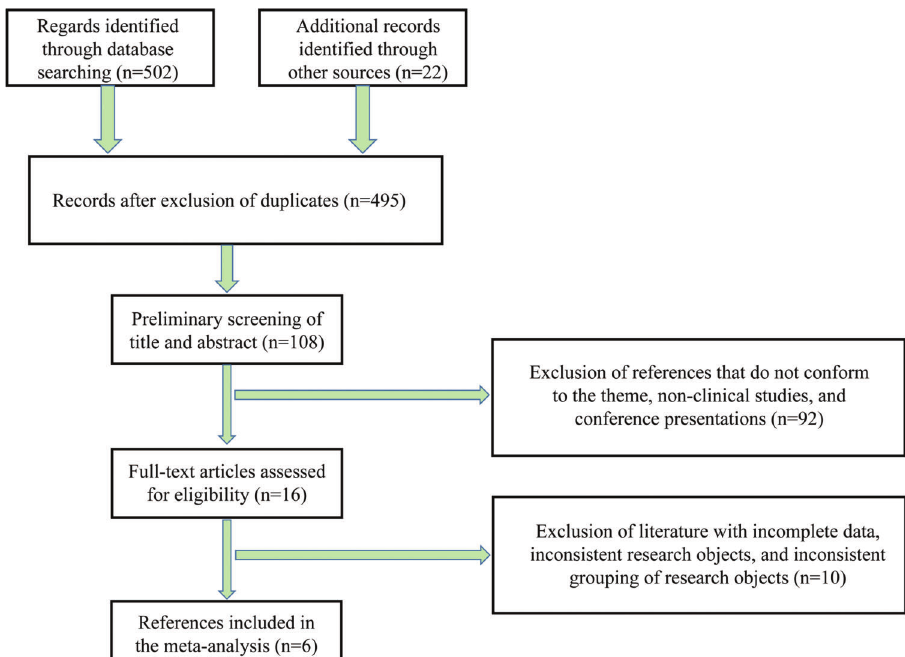
Figure 1 - Process of document inclusion.